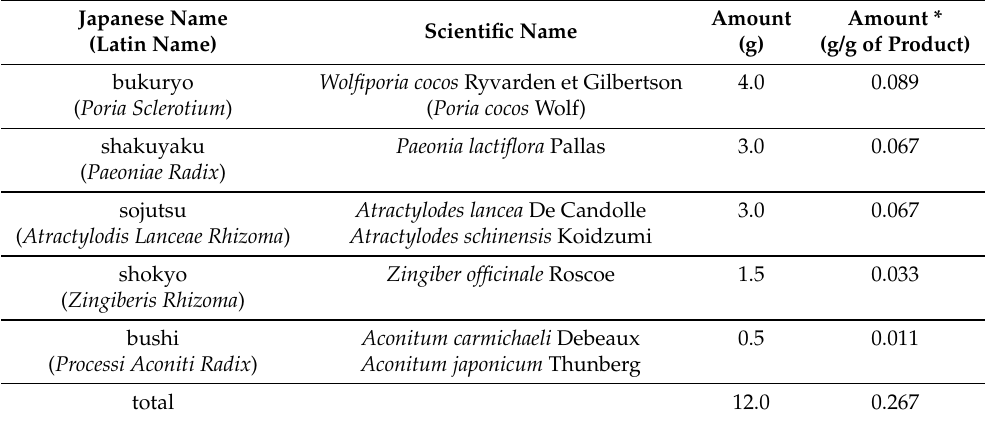
Table 5. The ingredients in the shinbuto (TJ-30) formula.